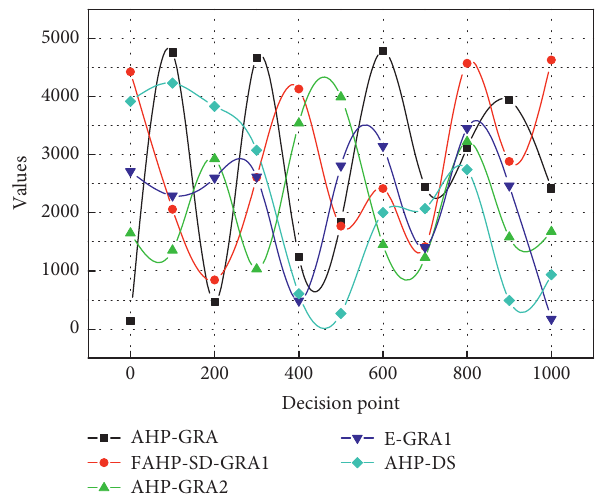
Figure 6: Network selection of each algorithm for different service types at each decision